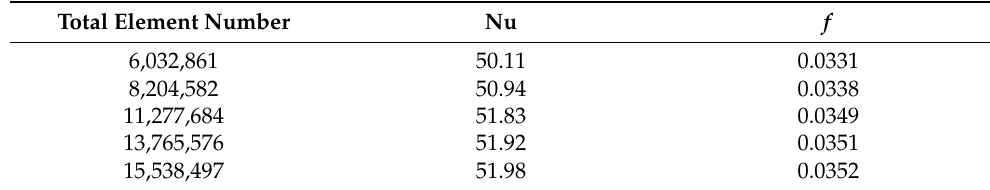
Figure 3. Grids generated for computation domain. Table 3. Grids independence test.